Question: Compose a caption that would accompany this figure in a paper.
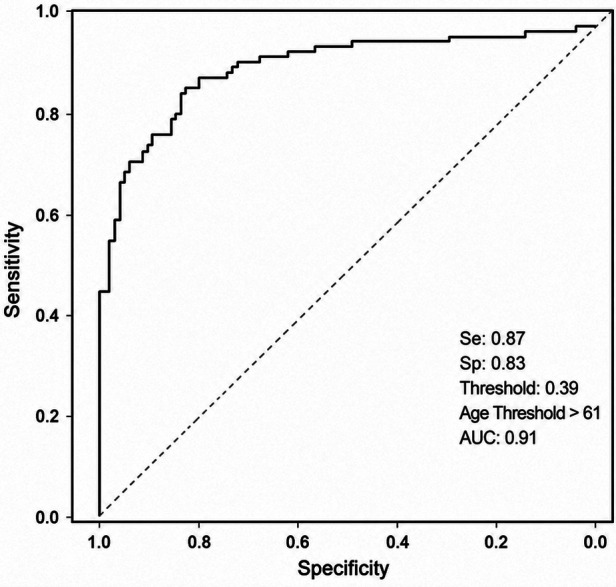
Answer: The receiver operating characteristic (ROC) curve, and the area under the curve (AUC) enabling discrimination between patients with structural abnormalities and those without. Sensitivity (Se) and specificity (Sp) were calculated for different probability thresholds, and the optimal threshold was identified.